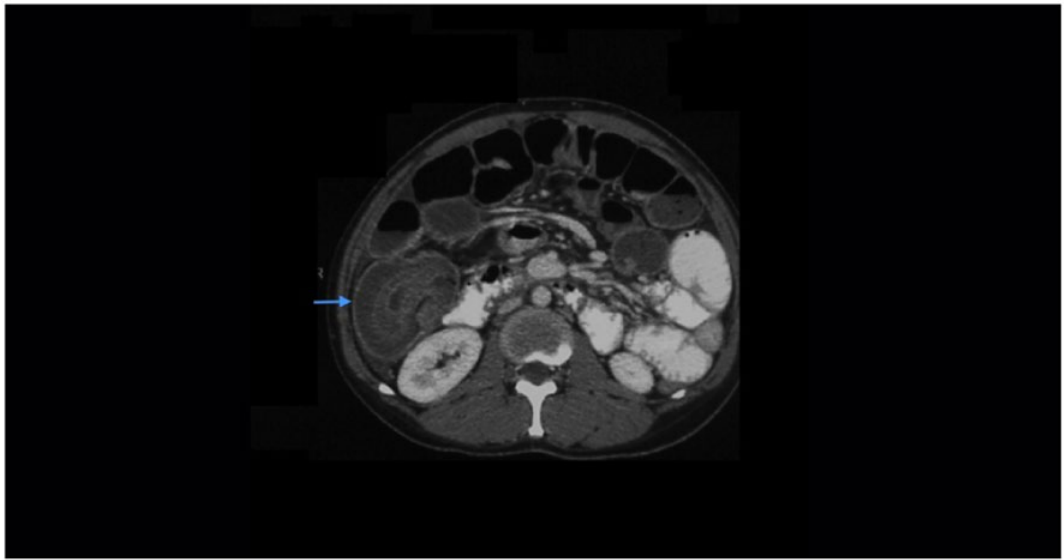
Figure 6f: Axial post-contrast CT showing a mass in the right iliac fossa (blue arrow) with alternating layers of low (mesenteric fat) and high attenuation (bowel wall) in keeping with ileocolic intussusception with SBO